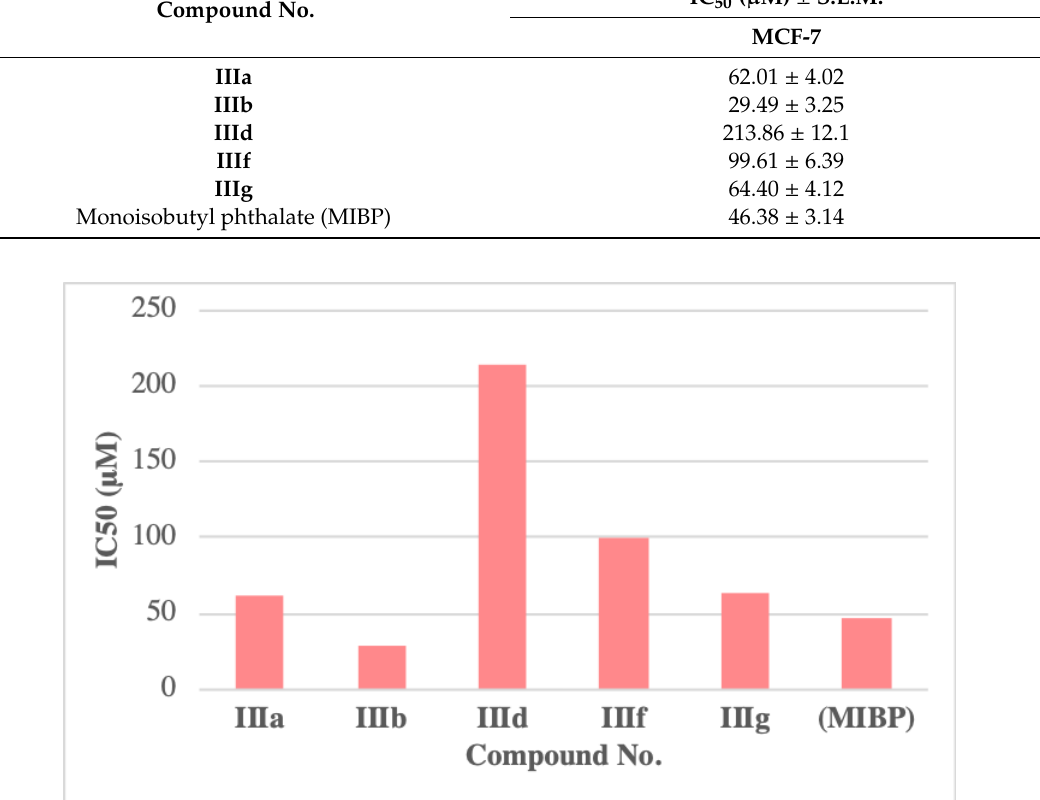
Figure 4. In vitro antiestrogenic activity of the selected synthesized compounds and MIBP. Figure 4. In Vitro antiestrogenic activity of the selected synthesized compounds and